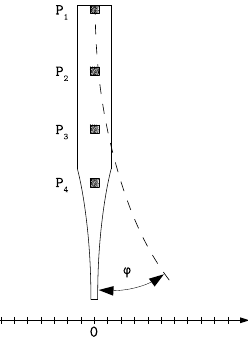
Figure 12. Top-view of the measurement setup with speckle patterns P1–P4 on four positions along the top-side of the robot. The angular displacement ϕ leads to a deflection of the speckle patterns in the x -direction that are captured by the